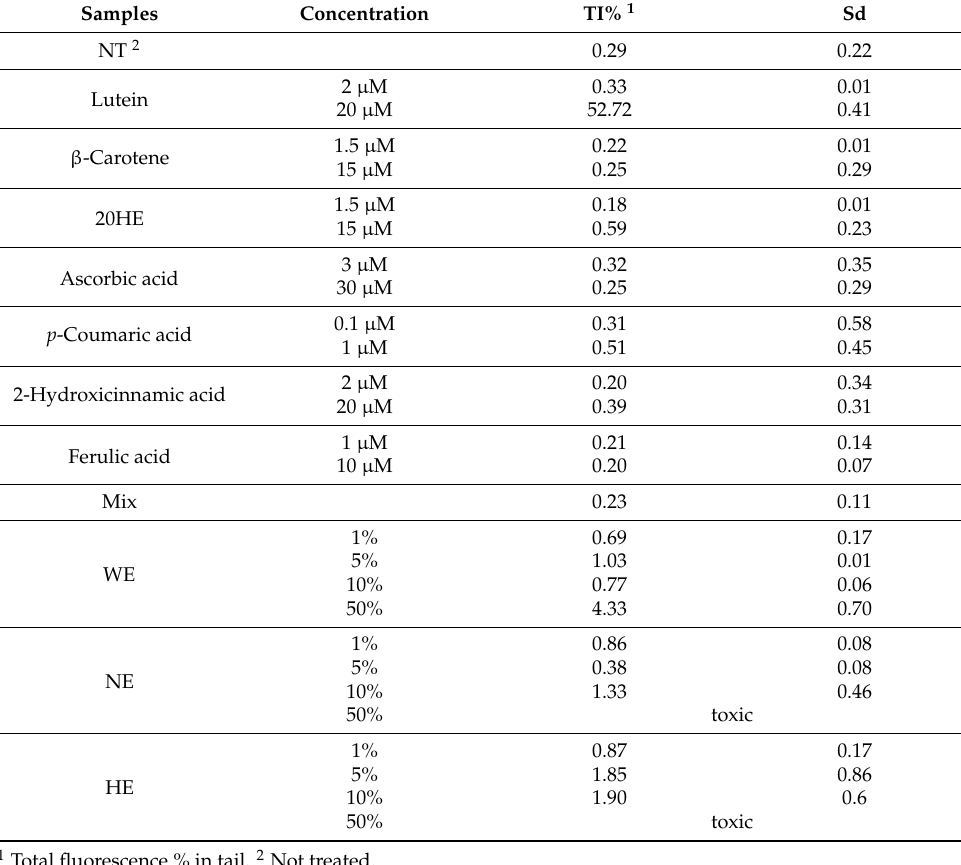
Table 2. Genotoxic effects of the different phytochemicals and extracts.